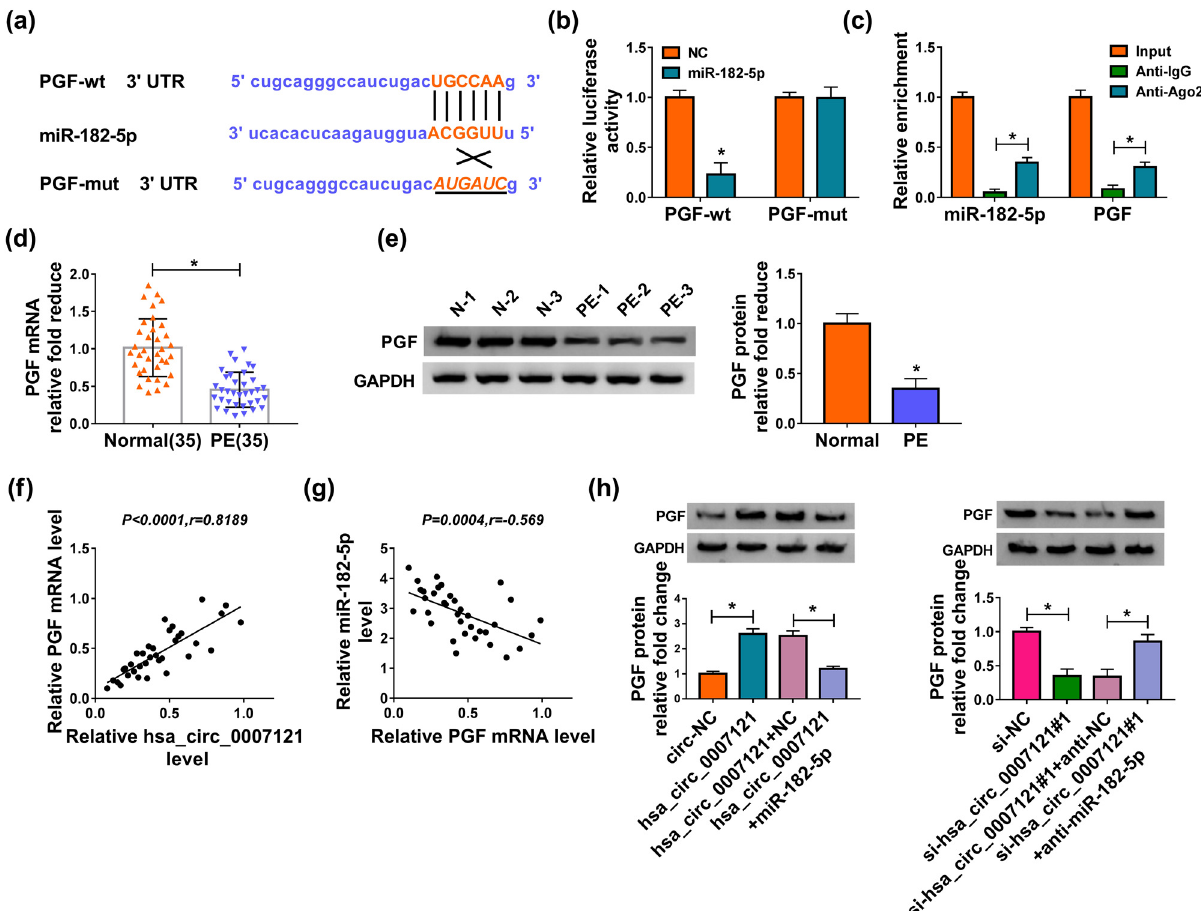
Figure 5: MiR - 182 - 5p bound to the 3 ’ UTR of PGF and negatively regulated PGF expression. ( a ) The putative binding sites between miR - 182 - 5p and PGF were predicated by ENCORI. ( b and c ) The interaction between miR - 182 - 5p and PGF was explored by the dual - luciferase reporter assay and RIP assay. ( d and e ) The mRNA and the protein levels of PGF in PE placental tissues ( n = 35 ) and normal placental tissues ( n = 35 ) were checked by qRT - PCR and western blot, respectively. ( f and g ) The correlation between PGF and hsa_circ_0007121 or miR - 182 - 5p in PE placental tissues was analyzed using Pearson ’ s correlation coe ffi cient. ( h ) The protein level of PGF in HTR - 8/SVneo cells transfected with hsa_circ_0007121, hsa_circ_0007121 + miR - 182 - 5p, si - hsa_circ_0007121#1, or si - hsa_circ_0007121#1 + anti - miR - 182 - 5p, as well as corresponding controls was checked by qRT - PCR. * P <